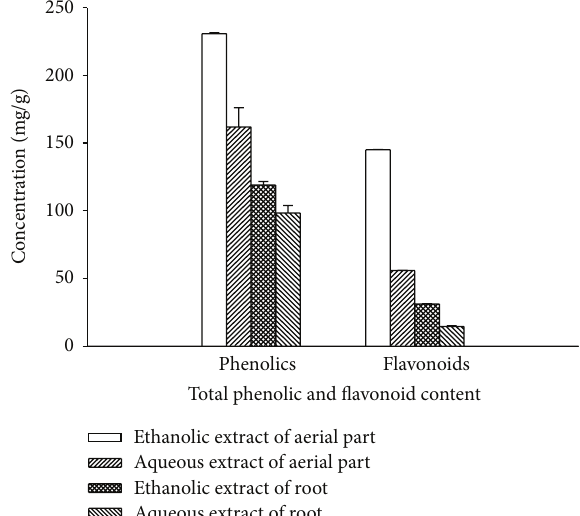
Figure 2: Total phenolic and flavonoid content in P. fraternus aerial part and